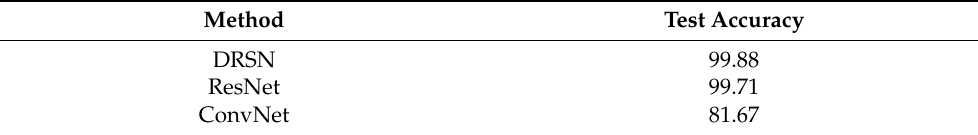
Table 7. Average accuracies of the DRSN, ResNet and ConvNet with Cauchy noise (%).